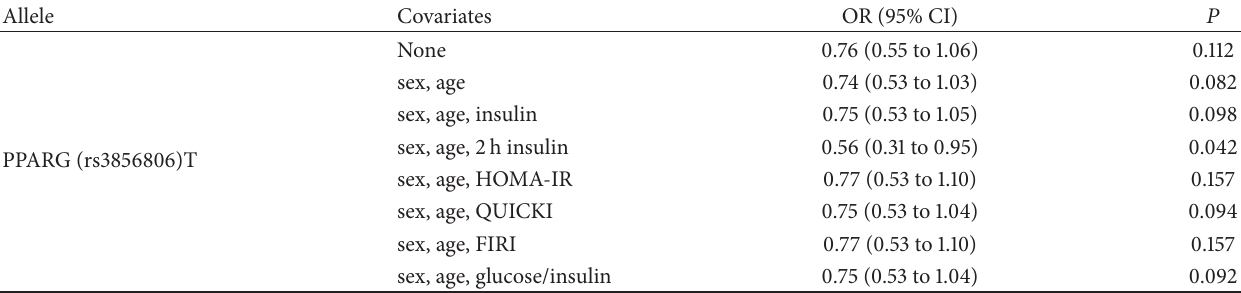
Table 4: Odds ratio and 95% confidence intervals from logistic regression for the prediction of diabetes.